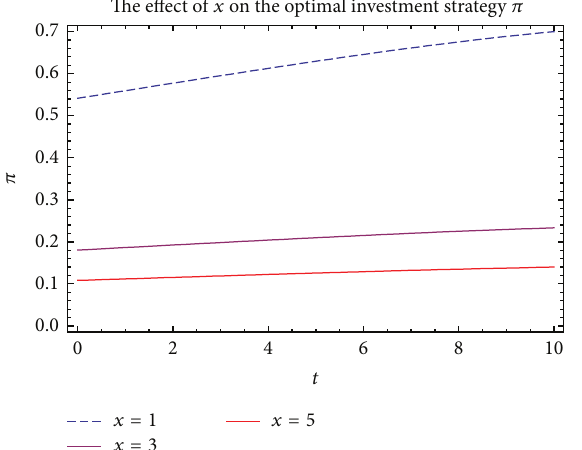
Figure 1: The optimal investment strategy 𝜋 decreases with respect to 𝑥 .